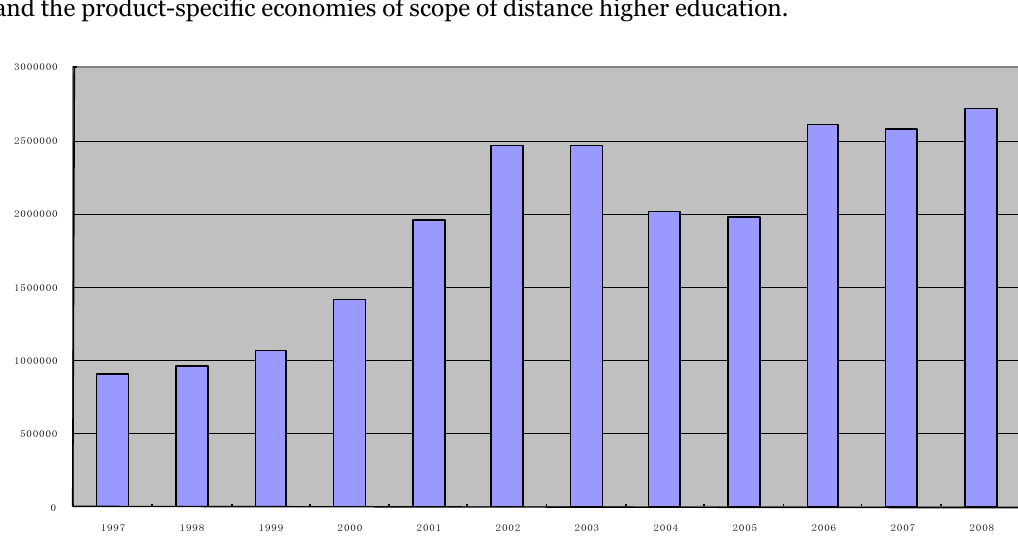
Figure 1. Enrollments of distance education in general HEIs from year 1997 to 2008 (Source: The Educational Statistics Yearbook of China 1998-2009